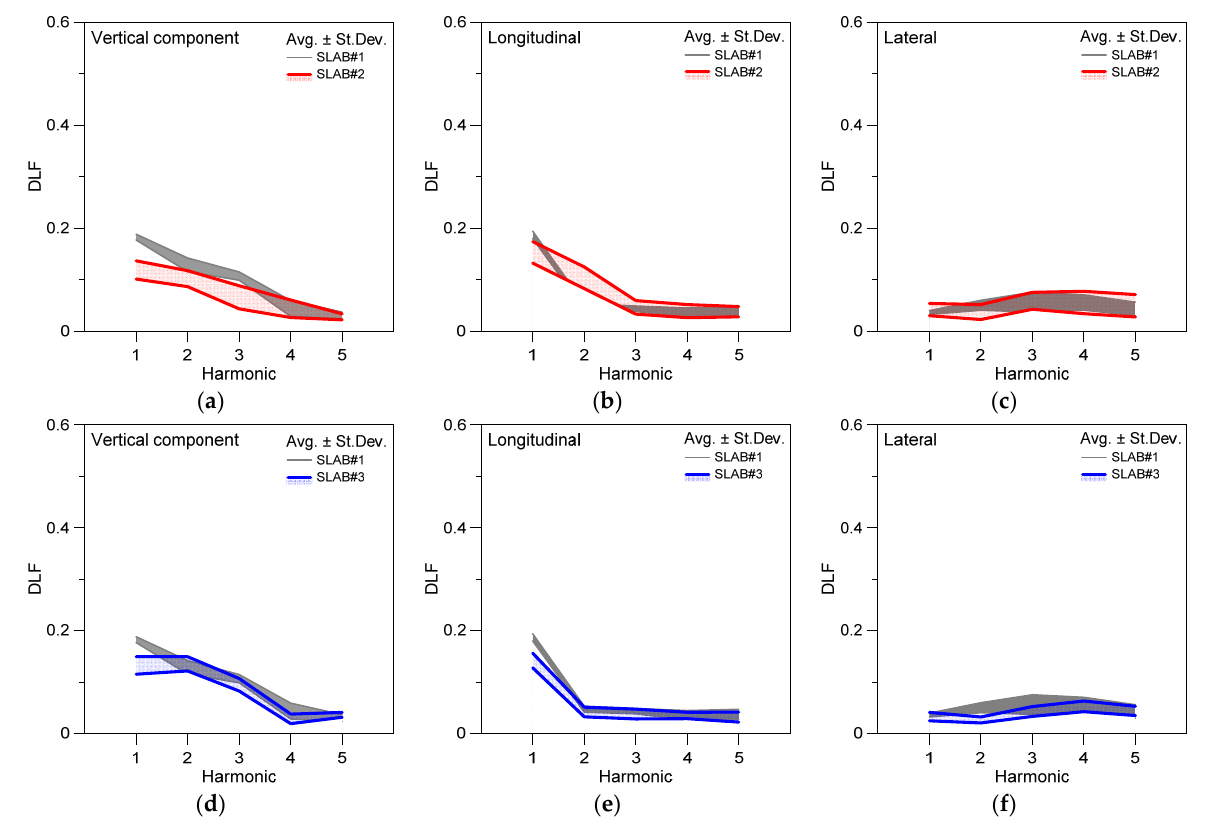
Figure 10. Experimentally derived DLF trends (average ± standard deviation), as a function of harmonic order, for a single adult volunteer under normal walks on rigid floor (SLAB#1) or flexible SLAB#2 and SLAB#3 transparent systems, with evidence of DLF values corresponding to ( a , d ) vertical, ( b , e ) longitudinal and ( c , f ) lateral force components based on body CoM measurements. DLF value ranges calculated based on eight walking records for SLAB#1, 10 for #2 and nine for #3.